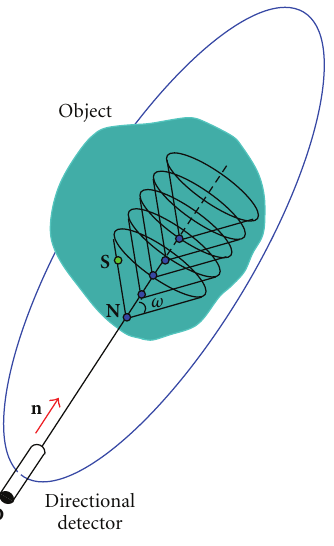
Figure 4: Compounded conical